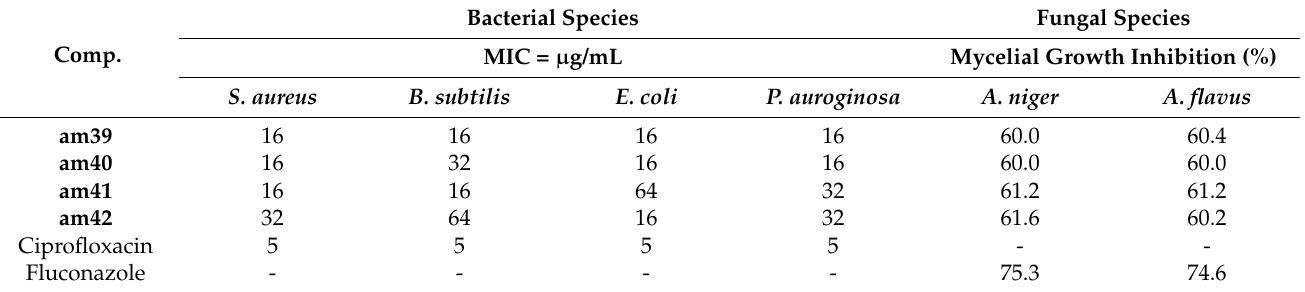
Table 17. Results of antimicrobial screening of the synthesized compounds (am39 – am42 ).